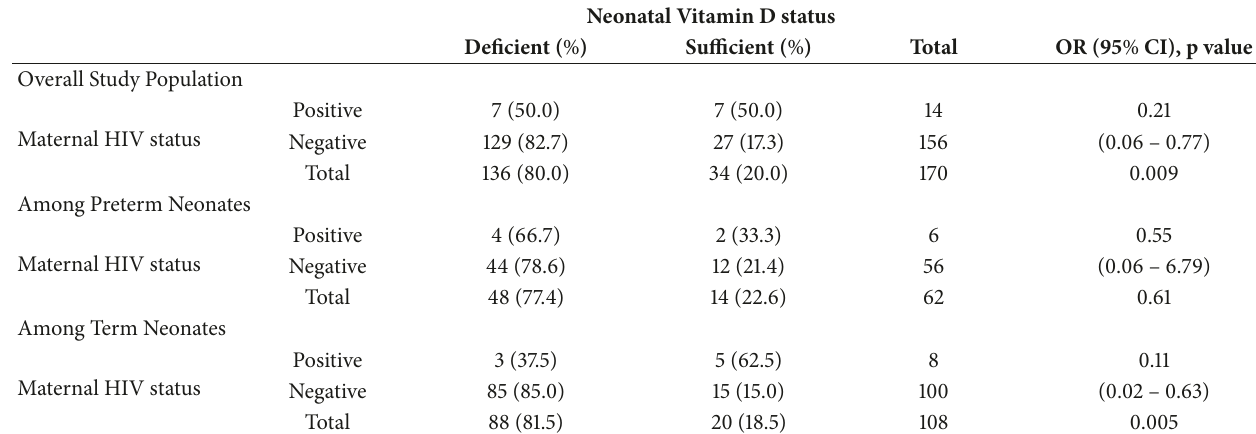
Table 3: Maternal HIV status against neonatal vitamin D status.